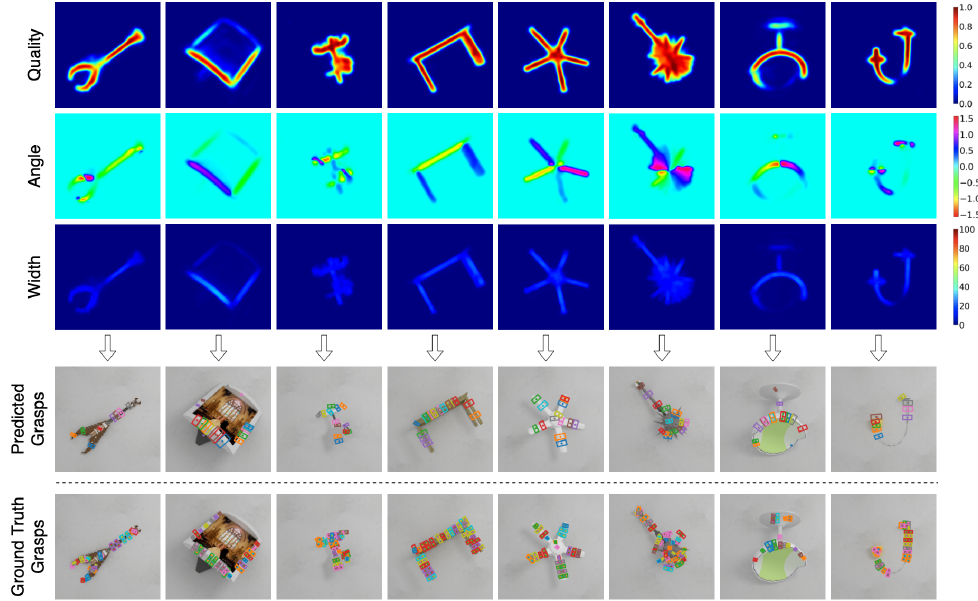
Figure 8. Qualitative results on Jacquard Grasping Dataset. The top three rows (quality, angle and width) are the output of GR-Convnet. The bottom two rows are the predicted and ground truth grasps in rectangle grasp